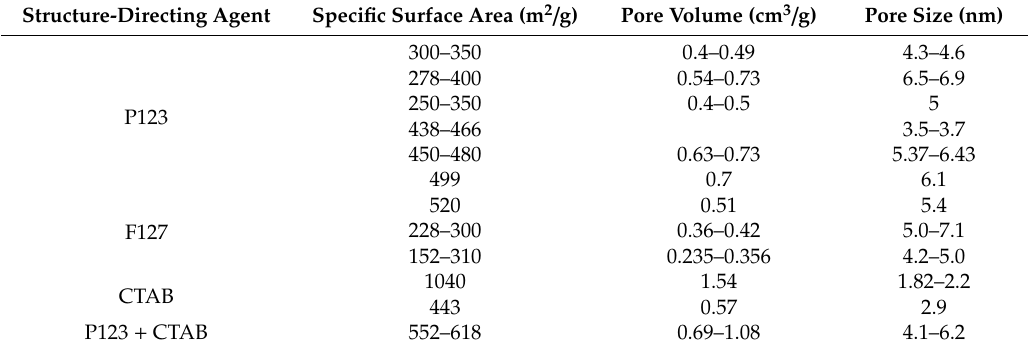
Figure 8. Typical TEM images of F127-induced MBGs ( a ), in which the pore and wall structures are indicated by white lines in ( b ) [49]. Table 1. Textural characteristics of MBGs prepared by using di ff erent structure-directing agents [7]. Structure-Directing